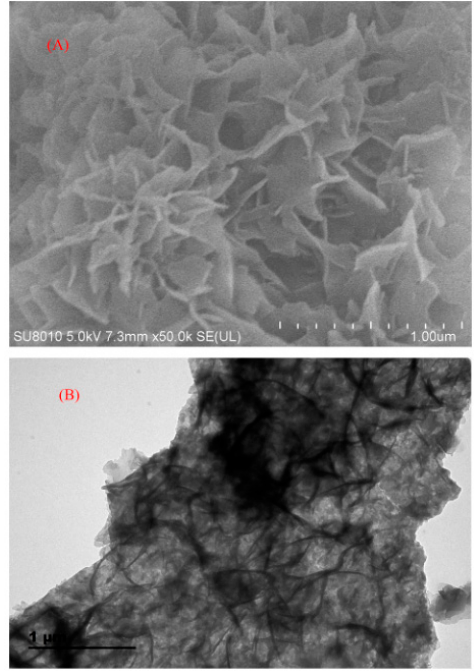
Figure 7. SEM ( A ) and TEM ( B ) images of NTM-COFs. Reprinted with permission from Ref. [93]. Copyright (2019) Elsevier.